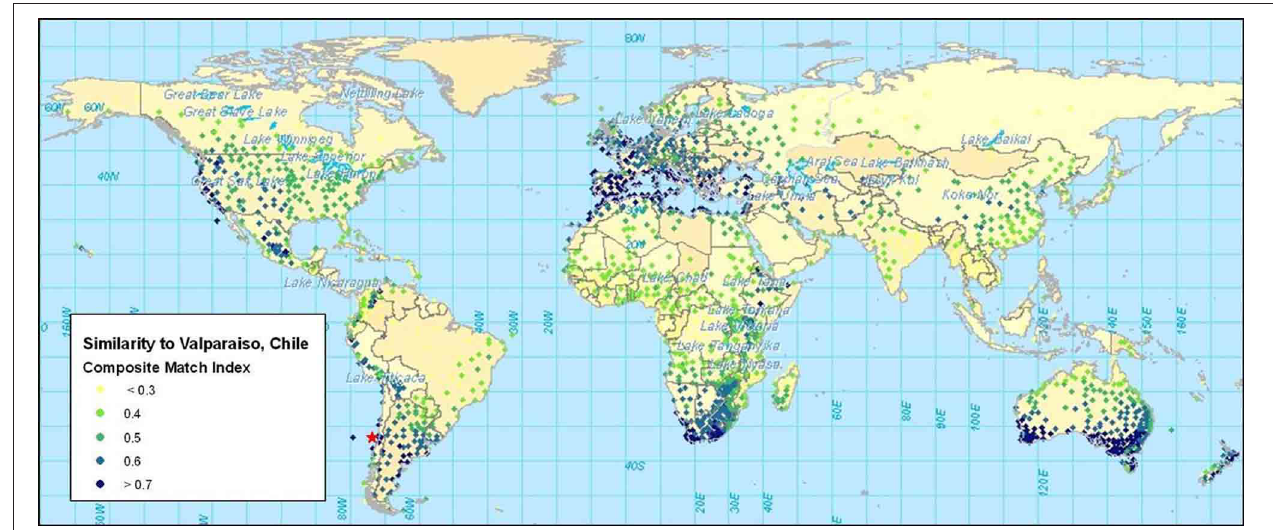
FIGURE 2 | The composite match index (CMI) showing the similarity of locations to Valparaiso,